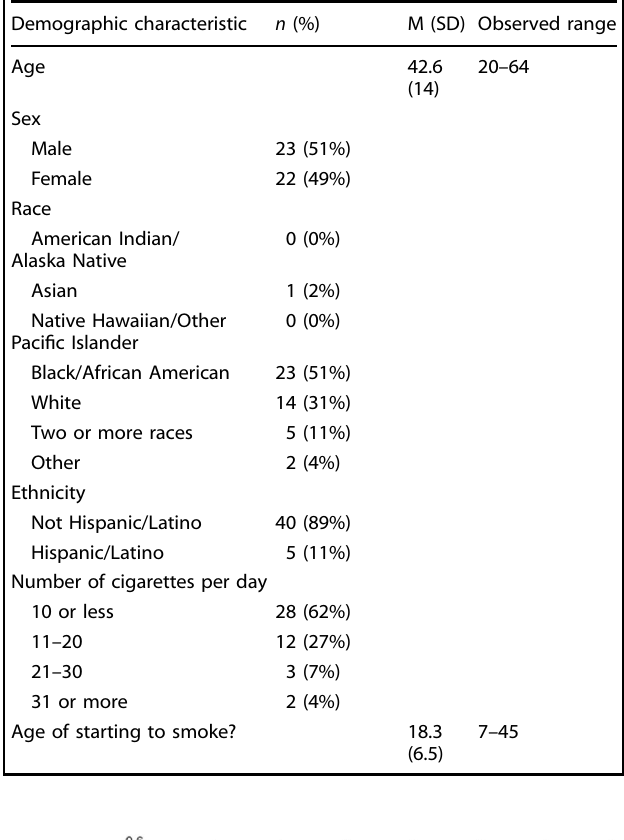
Table 1. Characteristics of the participants.